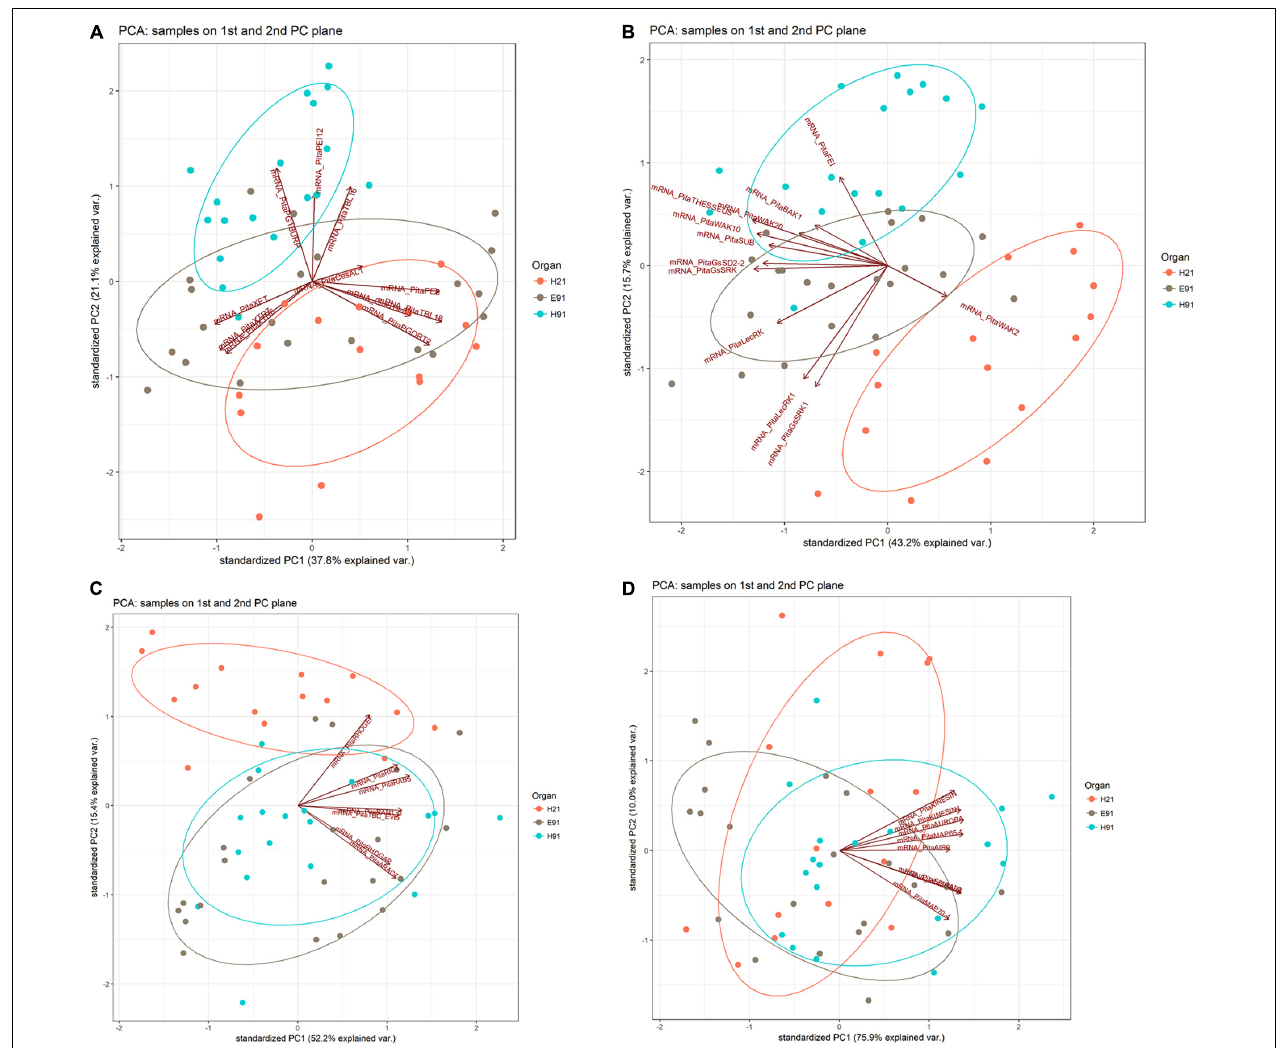
FIGURE 3 | Principal component analysis-biplot showing the expression distribution of genes encoding cell wall modification (A) , receptor-like kinases (B) , small GTPase-related (C) , and cytoskeleton-related (D) proteins in rooting-competent hypocotyl cuttings from 21-day-old seedlings (H21) and both non-competent hypocotyl (H91) and epicotyl (E91) cuttings from 91-day-old-seedlings in a two-dimension surface extracted from the principal component